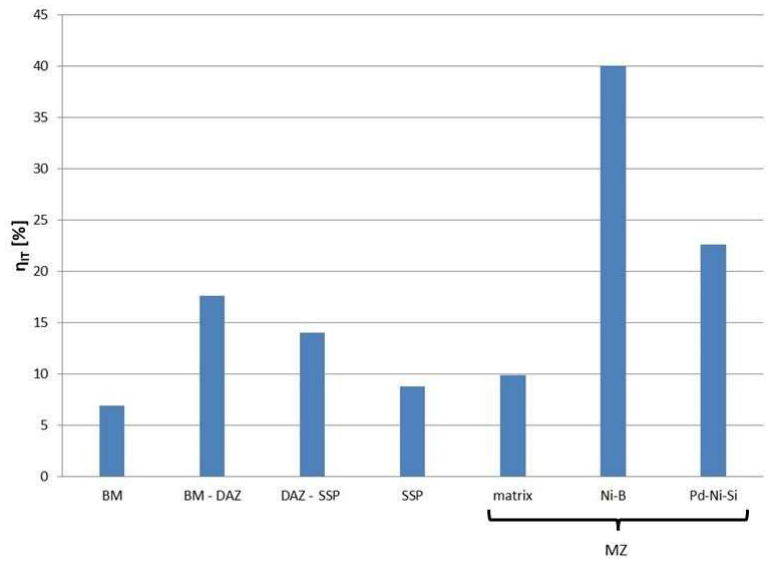
Figure 14. The relative percentage of elastic part of the indentation work (elastic to total work ratio) for structure elements of Hastelloy X–Palnicro 36M brazed joint.